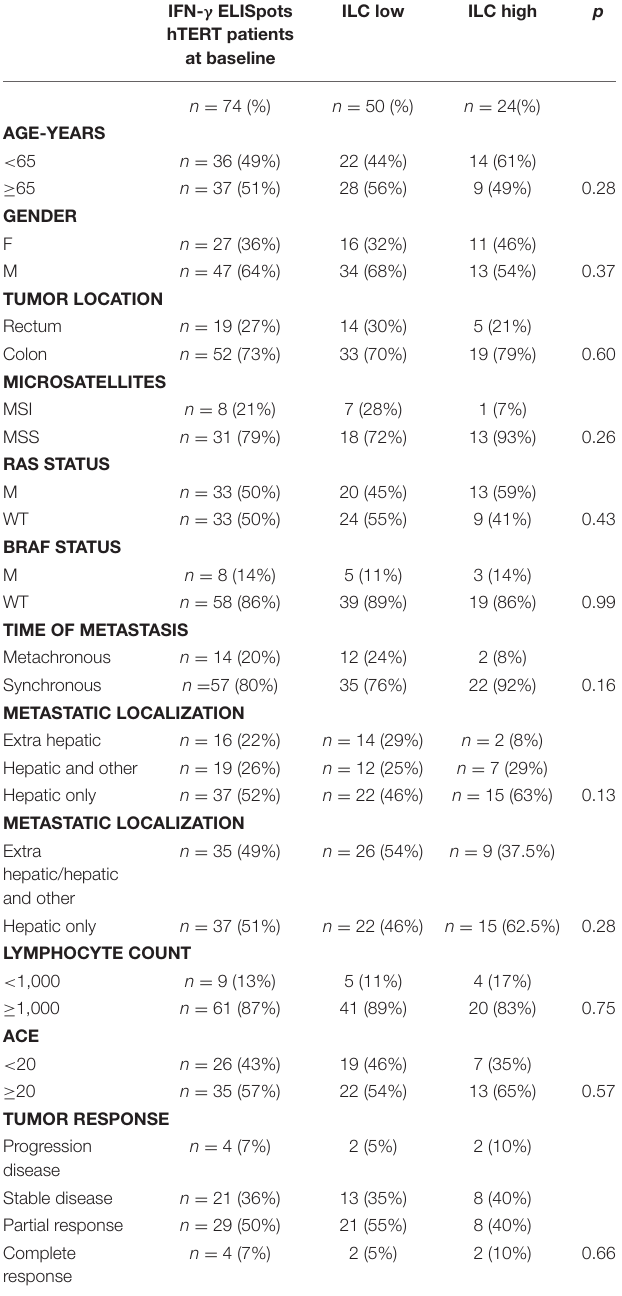
TABLE 1 | Clinicobiological characteristics of patients based on their ILC distribution. IFN- γ ELISpots hTERT